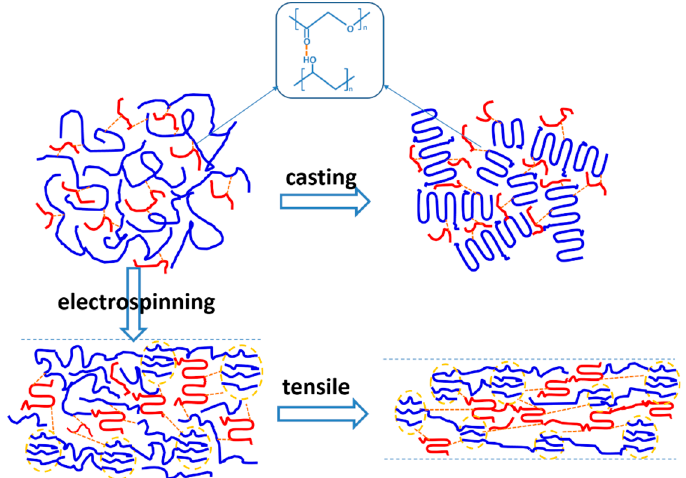
Figure 8. Schematic illustration of the miscibility evolution between PLA and PVA.